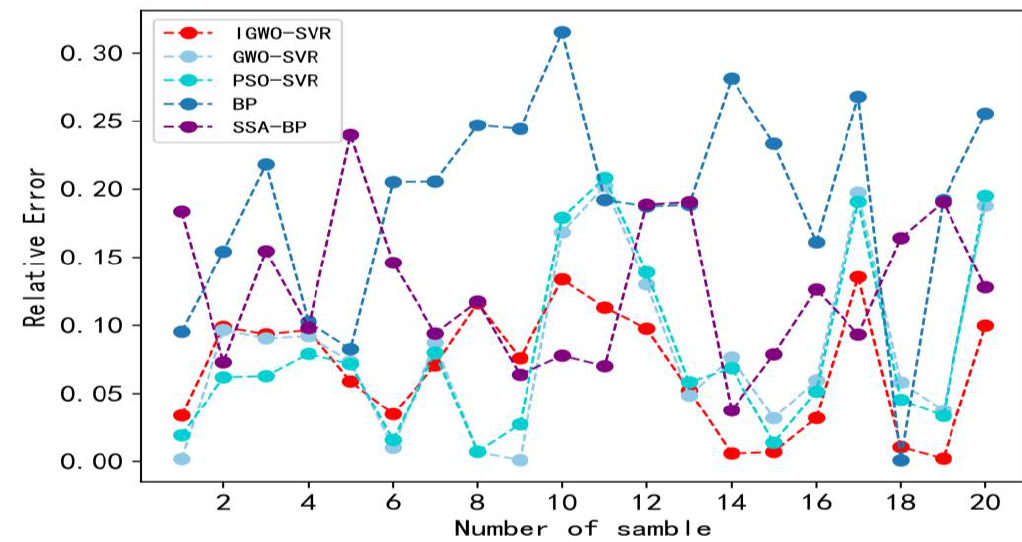
Figure 12. Relative errors of different models for rotation error prediction.